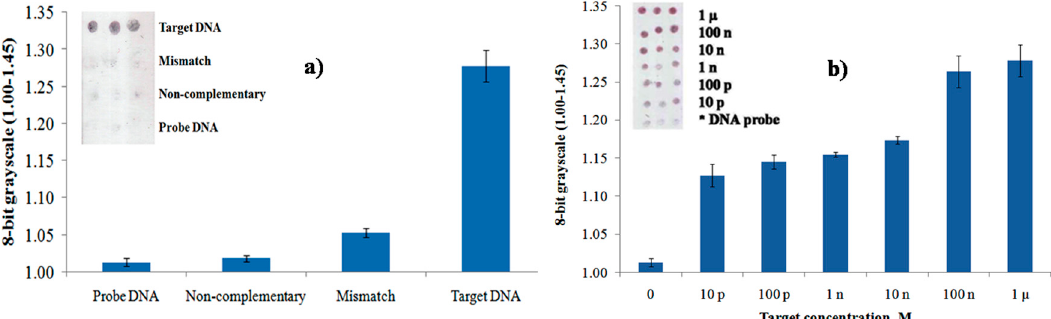
Figure 10. Graph of 8-bit grayscale values of 10 µM of probe DNA arrays respond towards ( a ) 1 µM of DNA solution of target complementary, mismatch and non-complementary ( b ) a range of complementary target concentrations (1 µM–10 pM), following nanoparticle treatment and enhancement process.